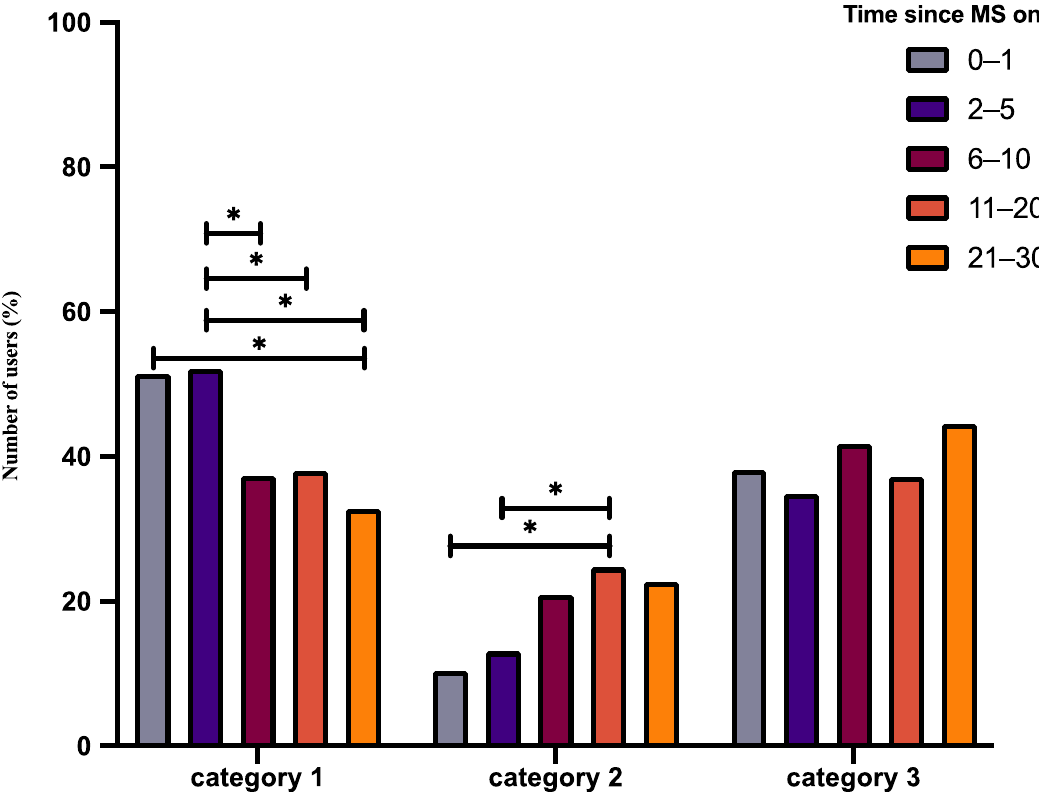
Figure 2. Medication taken by BRISA users with respect to time since MS diagnosis. The bar graphs above depict the relative frequencies of patients/users taking a specific medication between 0 and 30 years since MS diagnosis. The number of users in each medication group was normalized to the total number of users in that particular time group. * p < 0.05, see corresponding text for exact p - values.